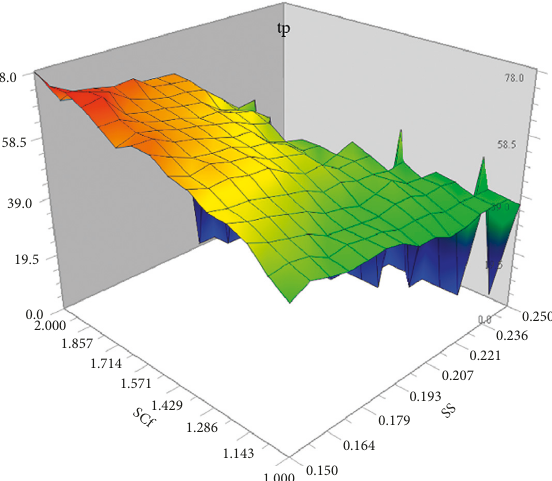
Figure 13: The 3D response surface plots for production time.